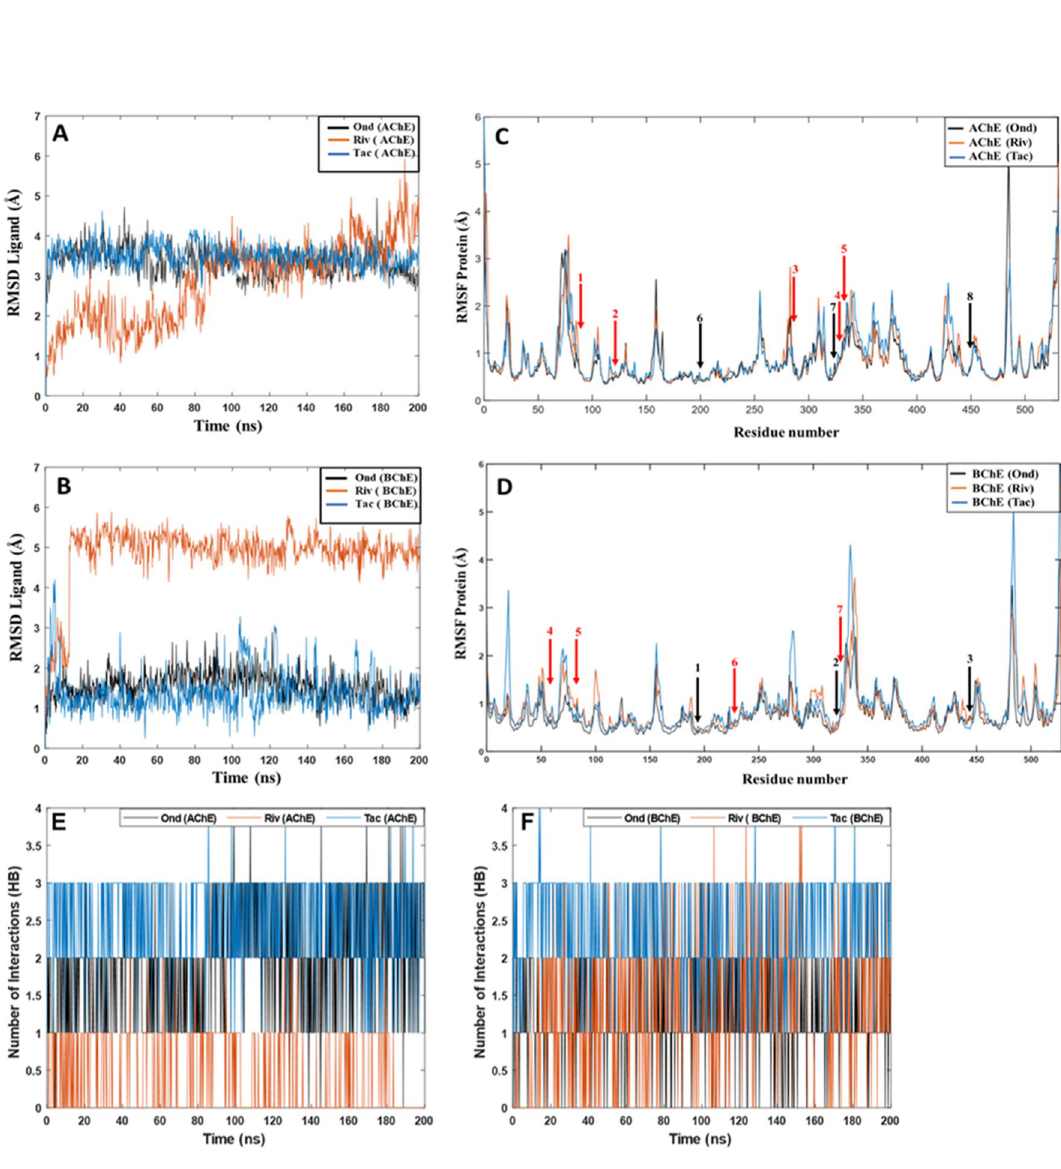
Figure 4. Root-mean-square deviation (RMSD) values of the AChE and BChE ligand complexes during 200 ns MD simulations: ( A ) Ondansetron, Tacrine, and Rivastigmine as ligands in AChE; ( B ) Ondansetron, Tacrine, and Rivastigmine as ligands in BChE. Root mean square fluctuation (RMSF) values of the AChE and BChE proteins during 200 ns MD simulations; ( C ) AChE containing Ondansetron, Rivastigmine, and Tacrine as ligands; ( D ) BChE containing Ondansetron, Rivastigmine, and Tacrine as ligands. Red and black arrows with numbers correspond to the location of peripheral residues and catalytic residues, respectively. ( E ) Hydrogen bonds between Ondansetron, Tacrine, and Rivastigmine as ligands in AChE; ( F ) Ondansetron, Tacrine, and Rivastigmine as ligands in